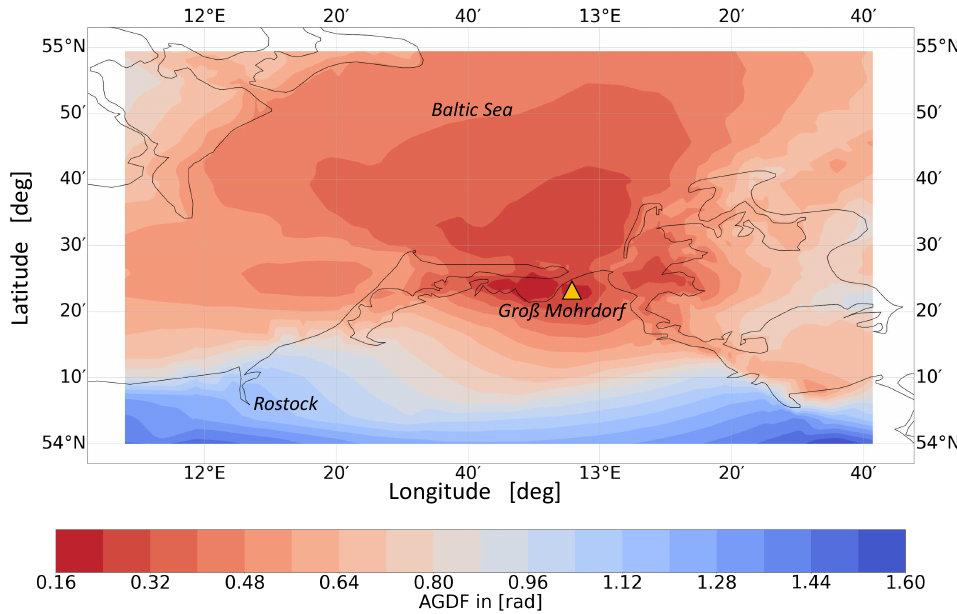
Figure 2. Groß Mohrdorf AGDF calculated for the southern Baltic Sea in